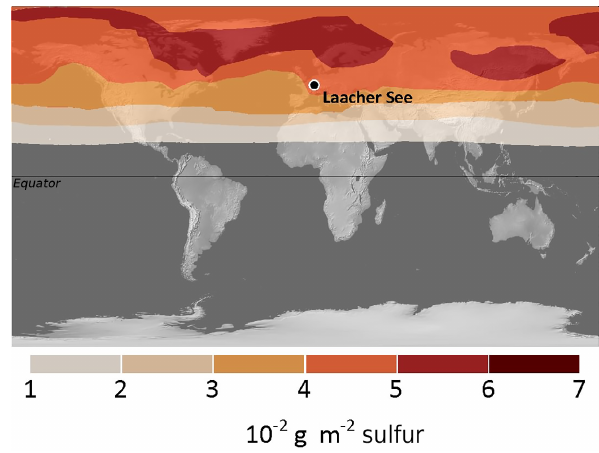
Figure 3. The distribution of the Laacher See volcanic cloud 6 months after the ∼ 12.9kaBP eruption based on existing climate model outputs (MAECHAM4 model) (Graf and Timmreck, 2001). The figure is redrawn based on the original in Graf and Timm- reck (2001), which contains details regarding the model and sim- ulation. This simulation assumed that the eruption injected 15Mt SO 2 into the lower stratosphere, ∼ 7 × less than the maximum esti- mate of Textor et al.